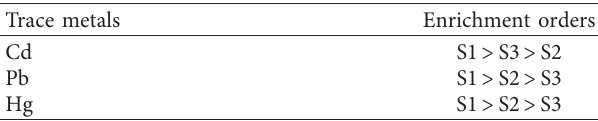
Table 9: The order of enrichment of stations for each trace metals in the fish